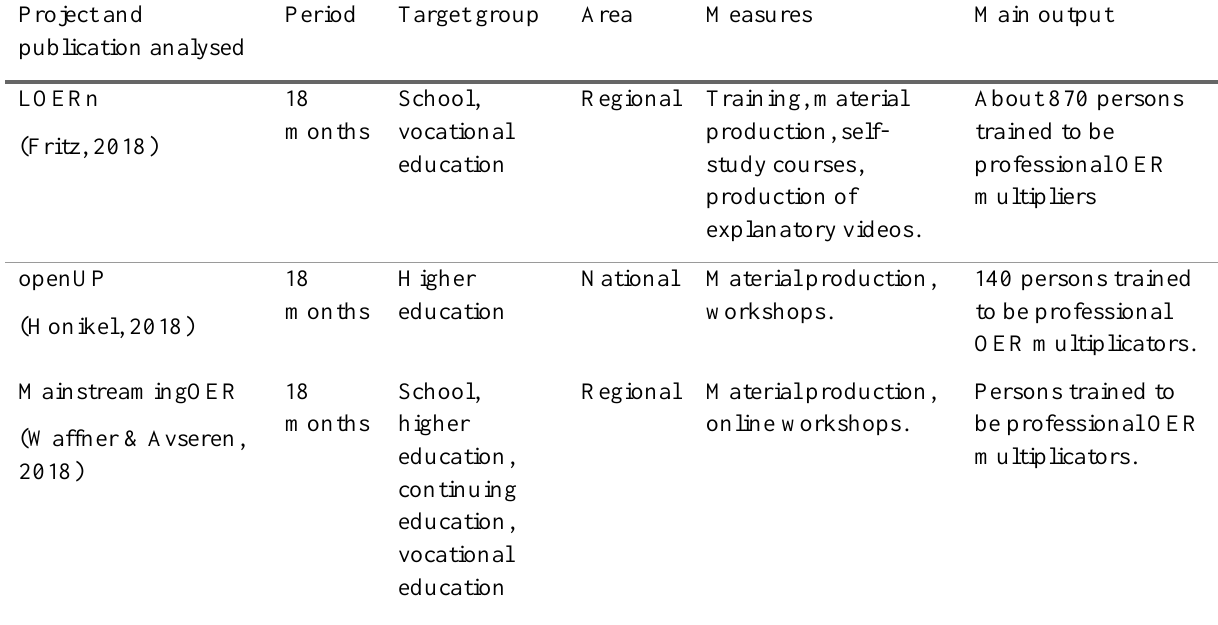
Overview of the 25 Projects Included in the Meta-Analysis Project